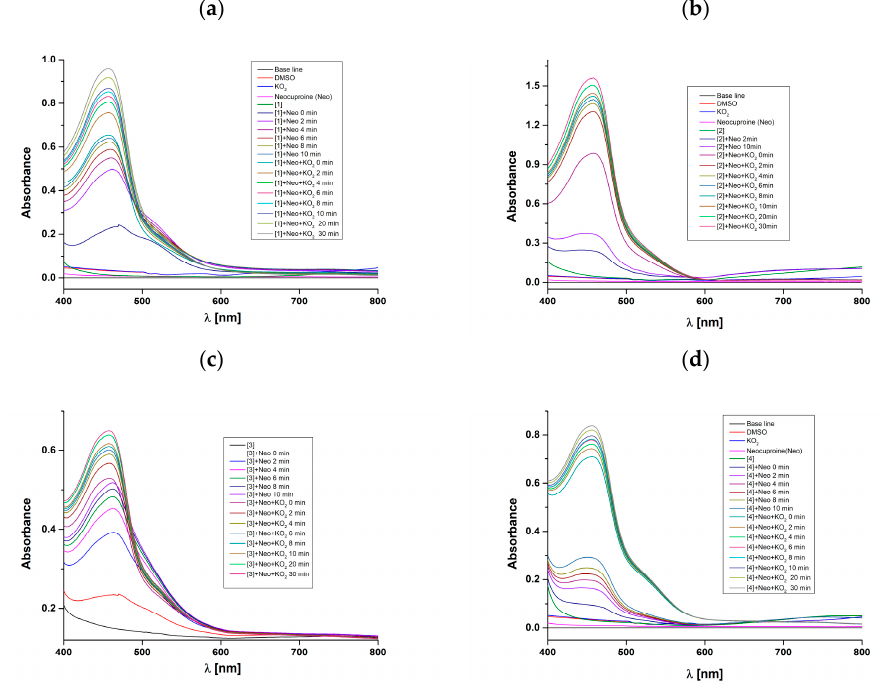
Figure 7. Time-dependent UV-Vis spectra of the interaction of studied complexes and KO 2 in DMSO in the presence of neocuproine: ( a ) 1 ; ( b ) 2 ; ( c ) 3 ; ( d )